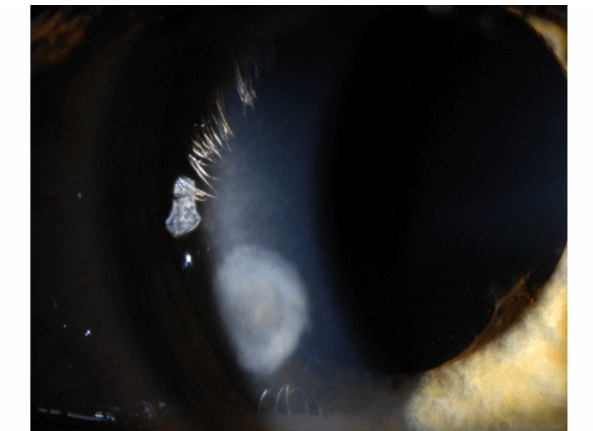
Figure 4: Result on last follow-up visit six months